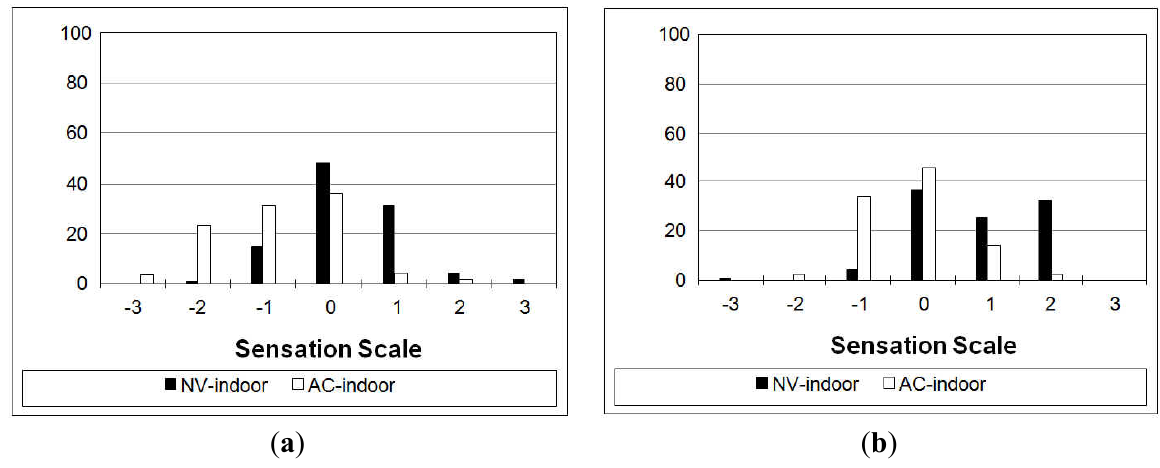
Figure 1. Relative frequency distribution (%) of thermal sensation votes in ( a ) the cool season; and ( b ) the warm season (NV = naturally ventilated; AC = air-conditioned).